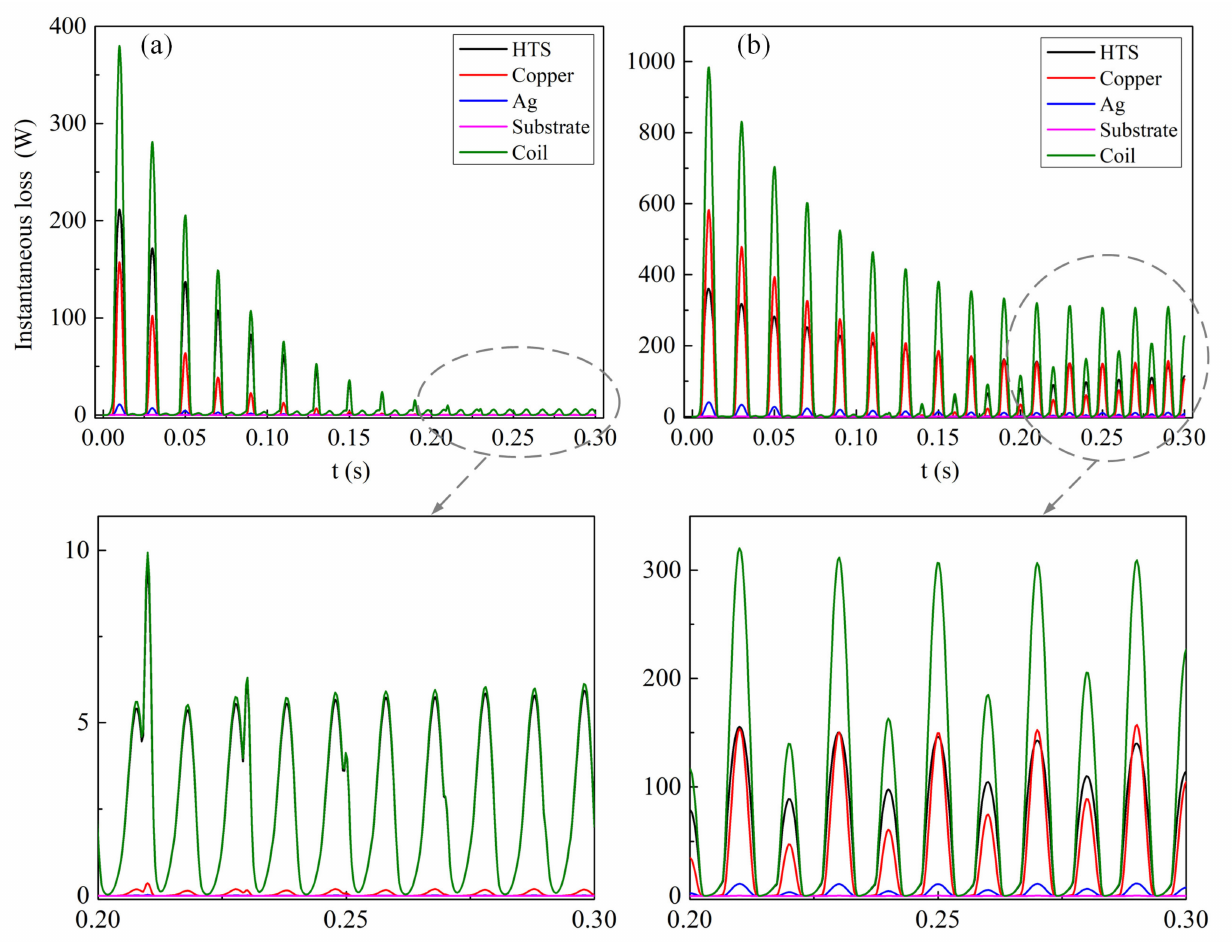
Figure 5. Change diagram of instantaneous loss in each part in the REBCO coil with time (( a ) I p / I c0 = 0.6, ( b ) I p / I c0 =